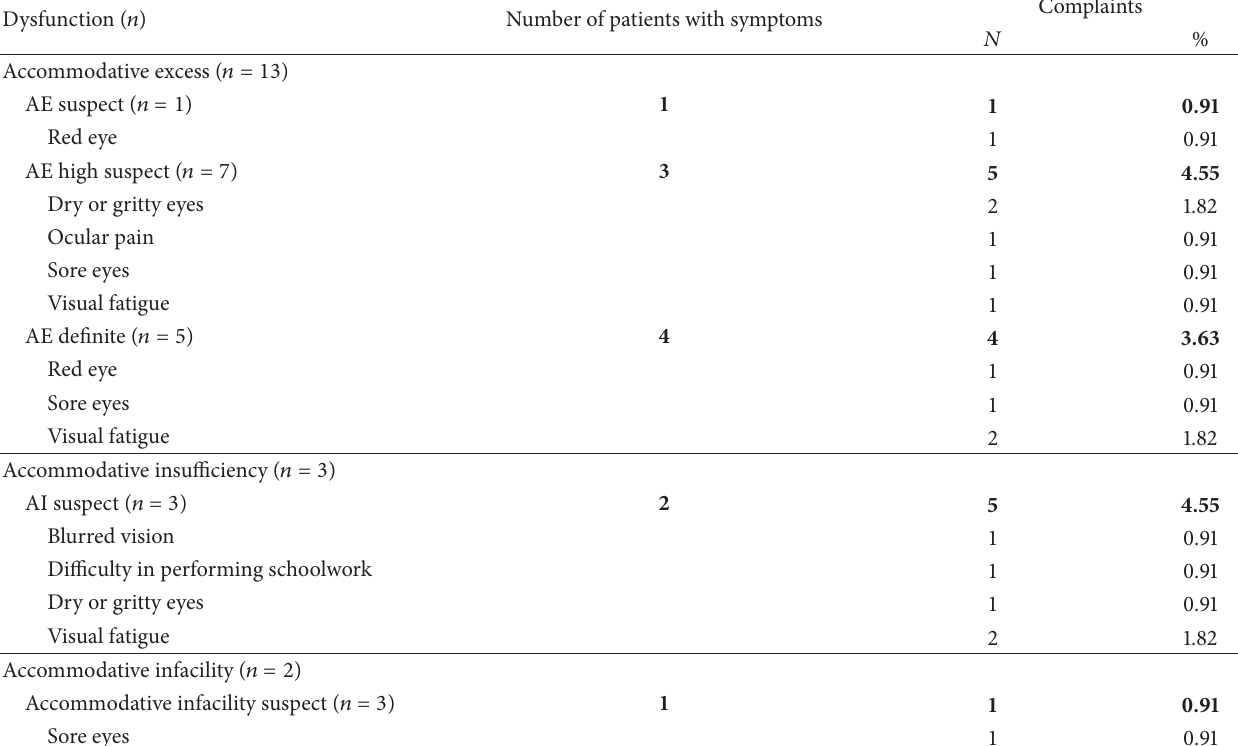
Table 4: Symptoms related to subjects with accommodative dysfunctions (AE: accommodative excess; AI: accommodative insufficiency). Dysfunction ( 𝑛